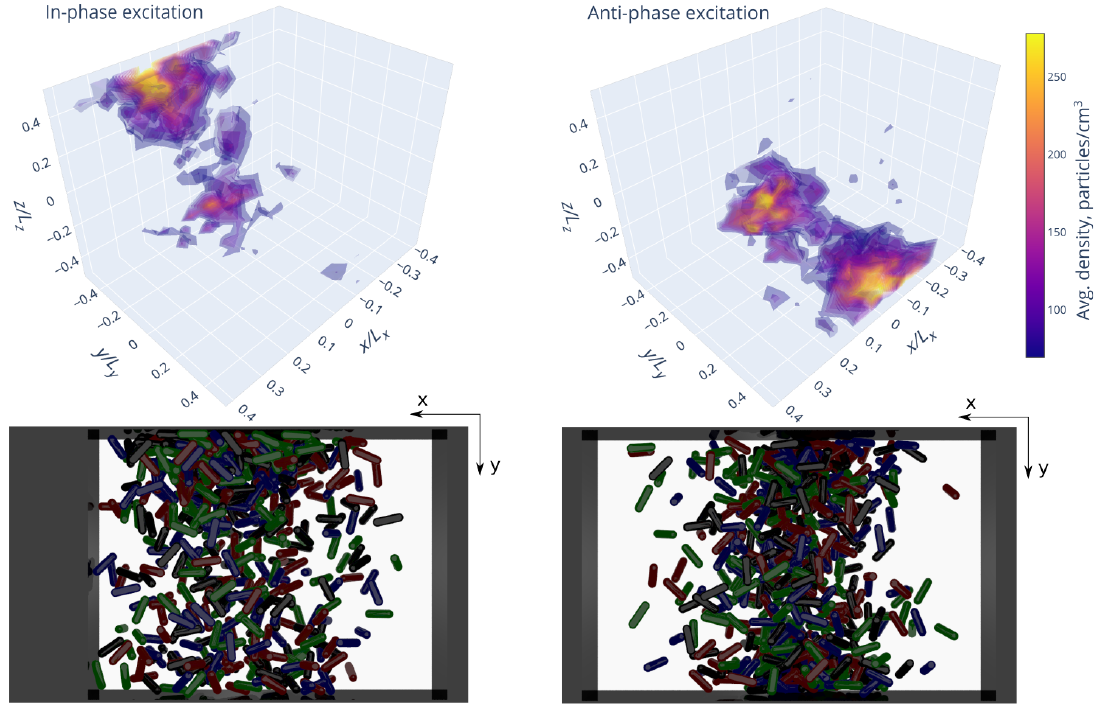
Figure 2. Isodensity surface plots for the simulated ensembles of 544 frictional rods. Density is averaged over 3 excitation periods. Left: in-phase excitation, right: anti-phase excitation. The formation of clusters is observed near the edges of the container. Below the 3D plots, the rendered simulation data of the respective ensembles are shown from the top view perspective.